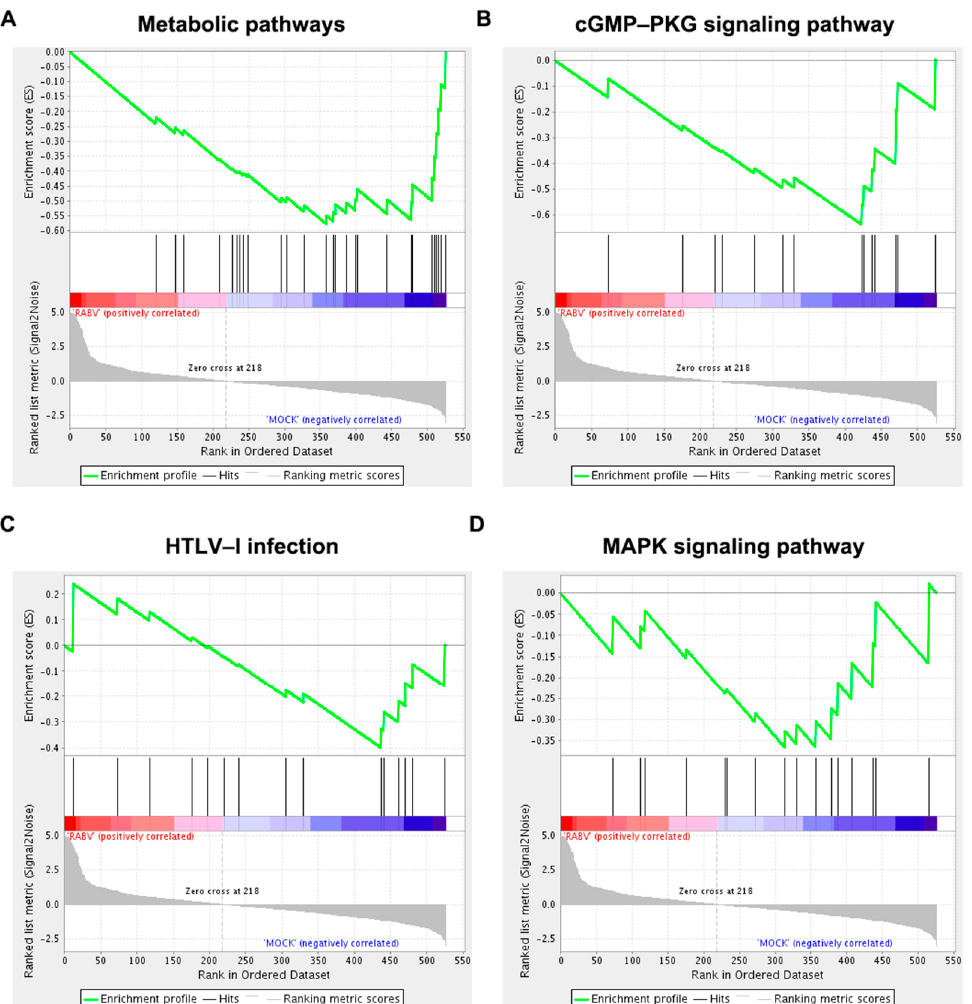
Figure 6. Representative 4 significantly enriched gene sets from GSEA analysis. Source genes of significantly differentially expressed circRNAs were specifically engaged in ( A ) metabolic pathways, ( B ) the cGMP–PKG signaling pathway, ( C ) HTLV-I infection, and ( D ) the MAPK signaling pathway.